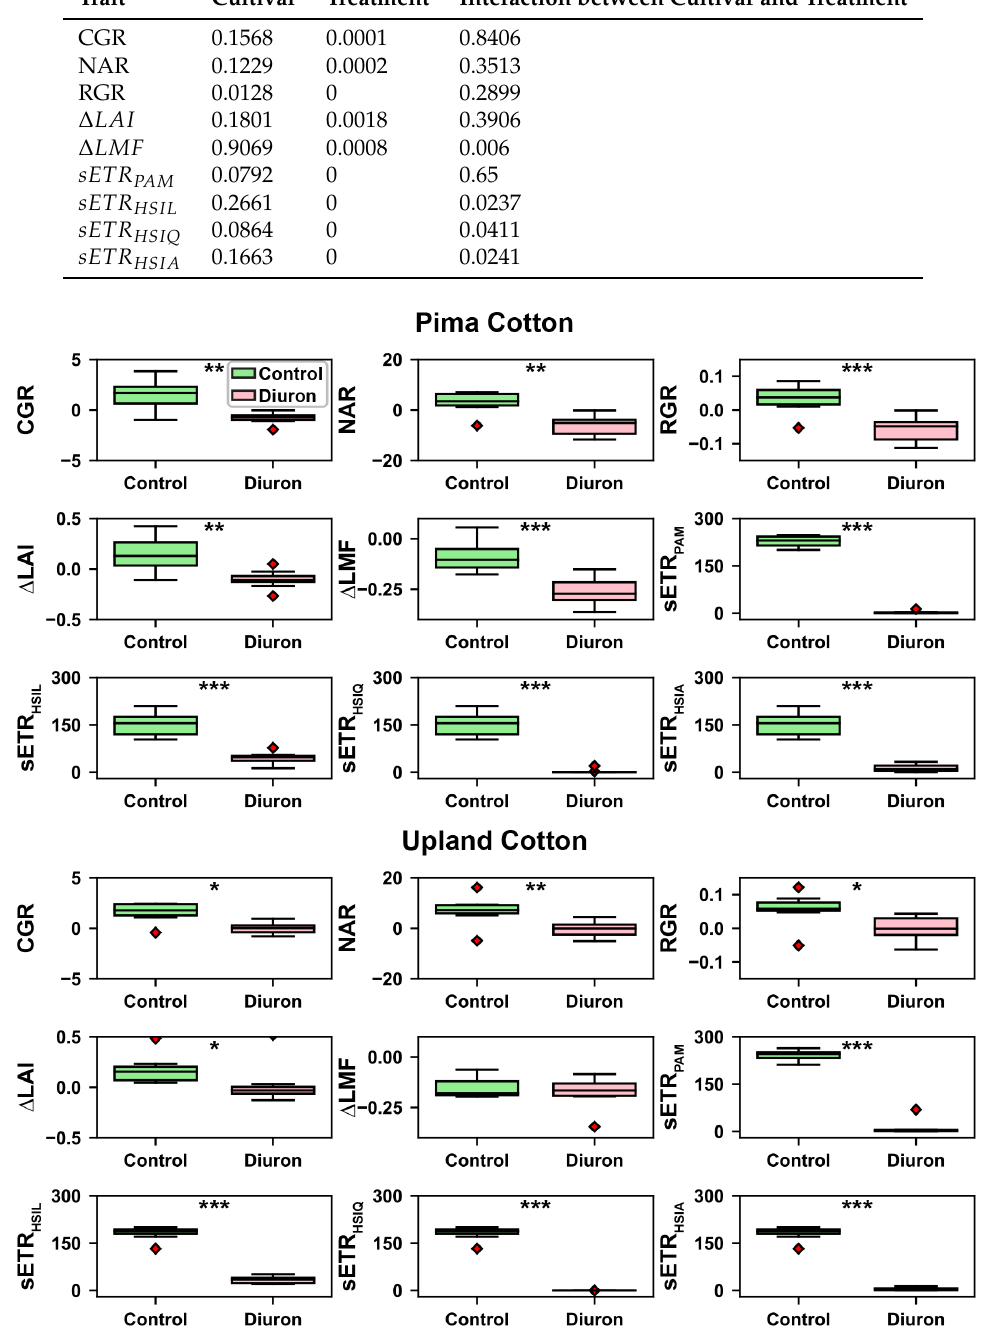
Figure 7. ANOVA tests on the growth traits and standardized ETR values estimated using four approaches. Asterisks indicate statistical differences between two treatments at different significance levels: * < 0.05, ** < 0.01, and *** < 0.001. CGR, NAR, RGR, and sETR values are in the units of g/m 2 /d, g/m 2 /d, g/g/d, and µ mol/m 2 /s,